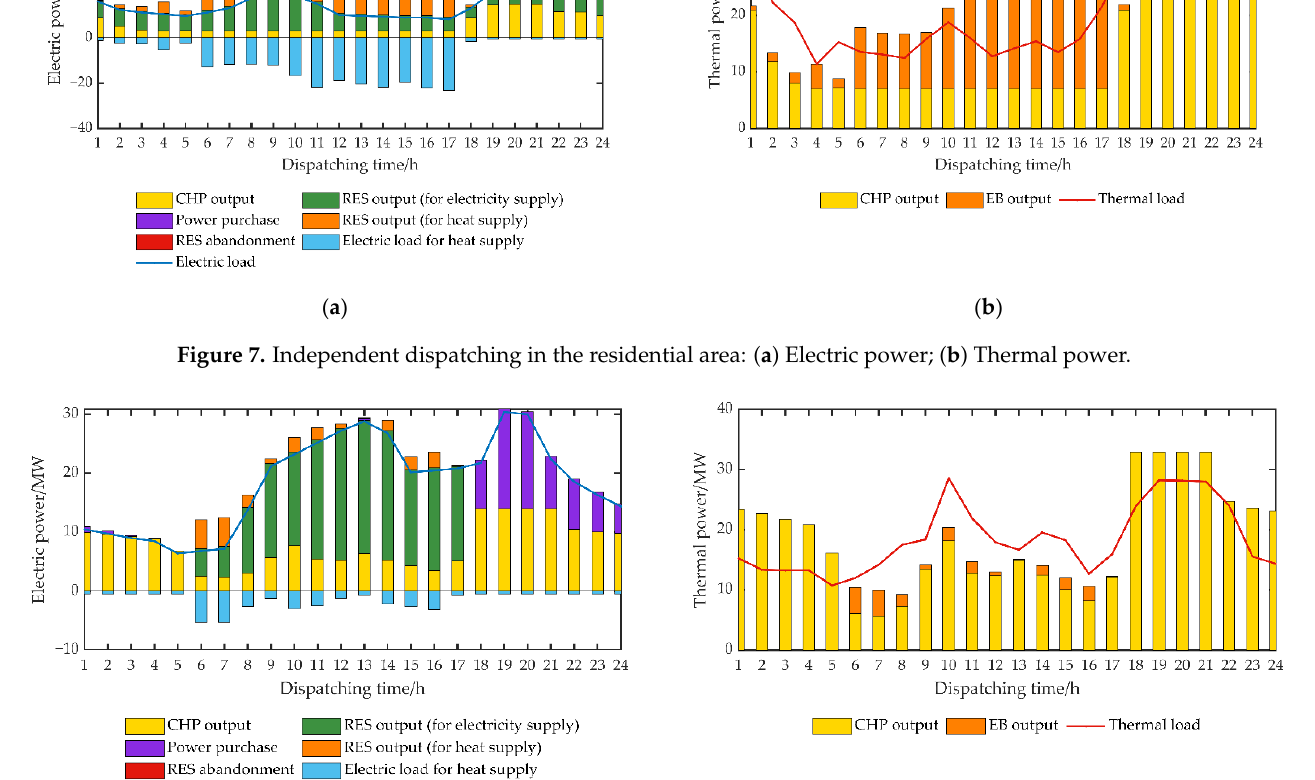
Figure 7. Independent dispatching in the residential area: ( a ) Electric power; ( b ) Thermal power.